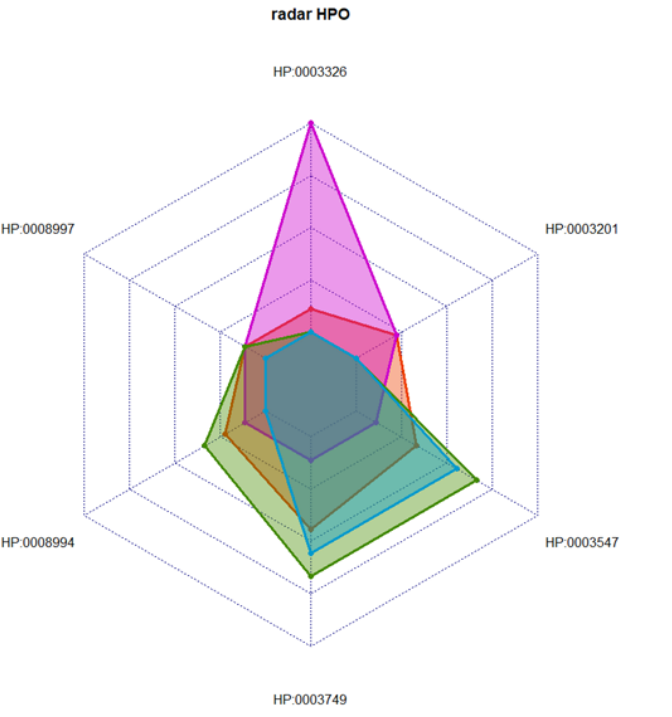
Figure 4. Distribution of frequencies of the most relevant clinical characteristics (indicated as HPO- based codes), shown per cluster.